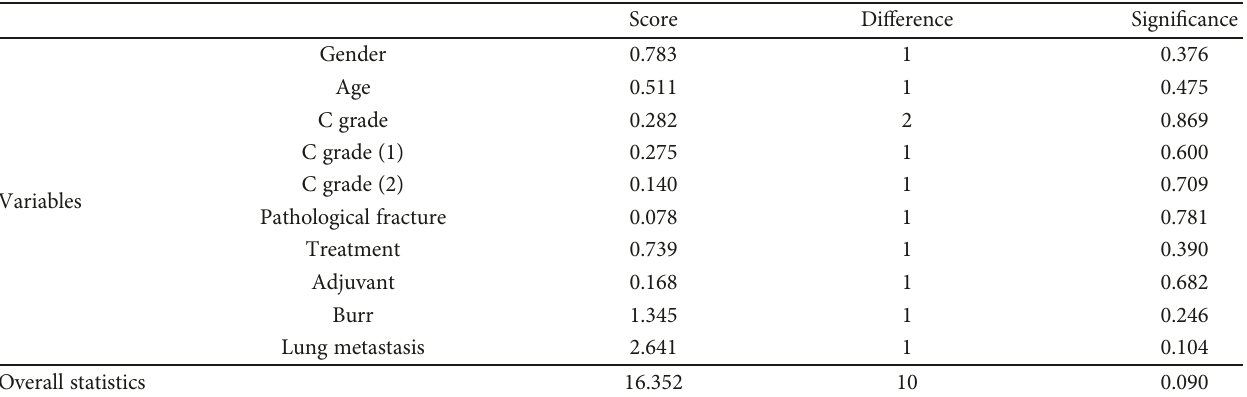
Table 3: Logistic regression analysis of the association between clinical characteristics and GCT